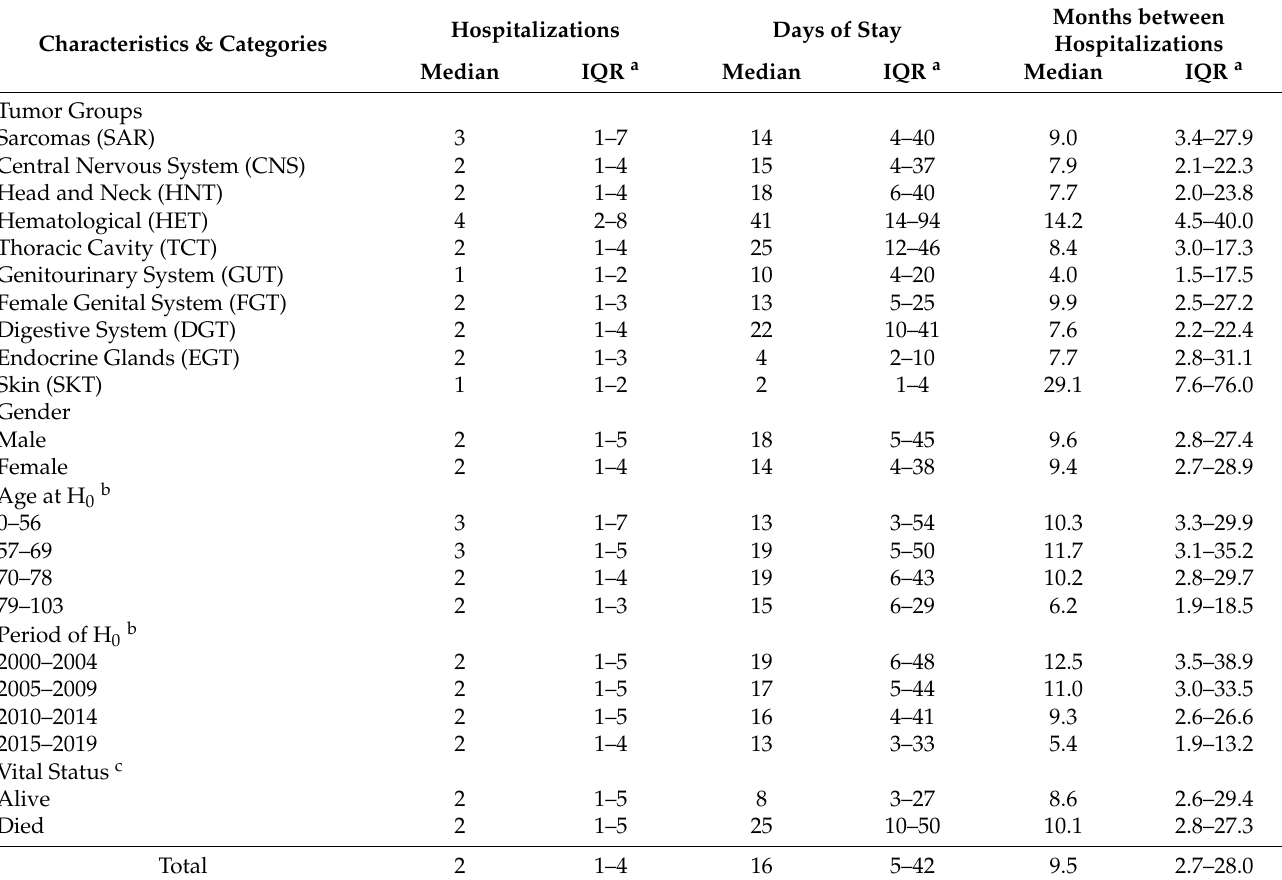
Table 2. Hospitalization characteristics of patients with rare tumors in Liguria Region during